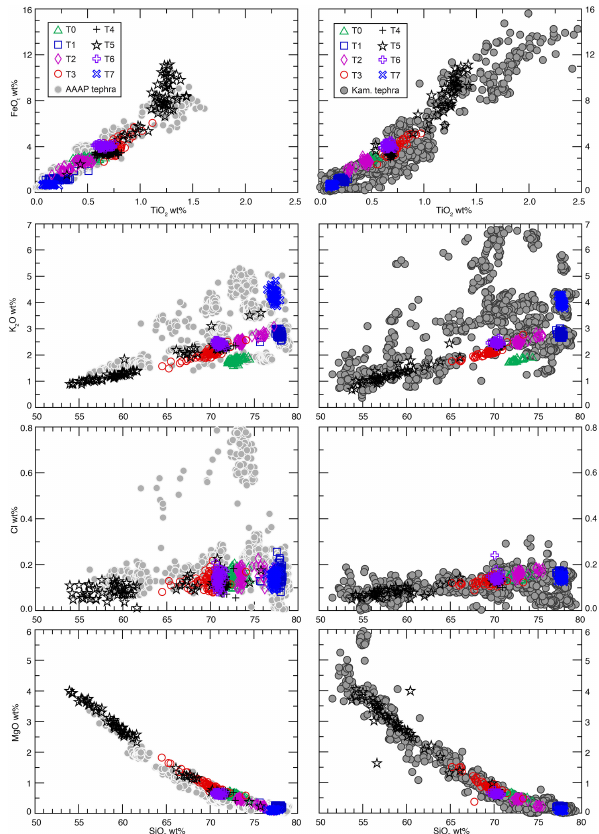
Figure 5. Harker diagrams for major-element geochemistry of T0– T7 in comparison to tephra from Kamchatka and the AAAP (Aleu- tian Arc–Alaska Peninsula). All data are single shard glass analy- ses normalized to 100%. Plots on the left compare data collected in Edmonton to a data set of AAAP tephra that have higher sim- ilarity coefficients ( > 0.90) to the tephra examined in this study. Compiled AAAP data were analyzed in Edmonton and are from the internal database, but are limited to tephra that have previously been reported in the literature. Plots on the right compare the major- element geochemical analyses collected in the Kiel laboratory to Pleistocene Kamchatkan eruptions. Although T0–T7 all plot within the fields designated by the AAAP and Kamchatkan data, they tend to plot more clearly with Kamchatkan data. This is particularly the case for the mafic oxides (e.g.,